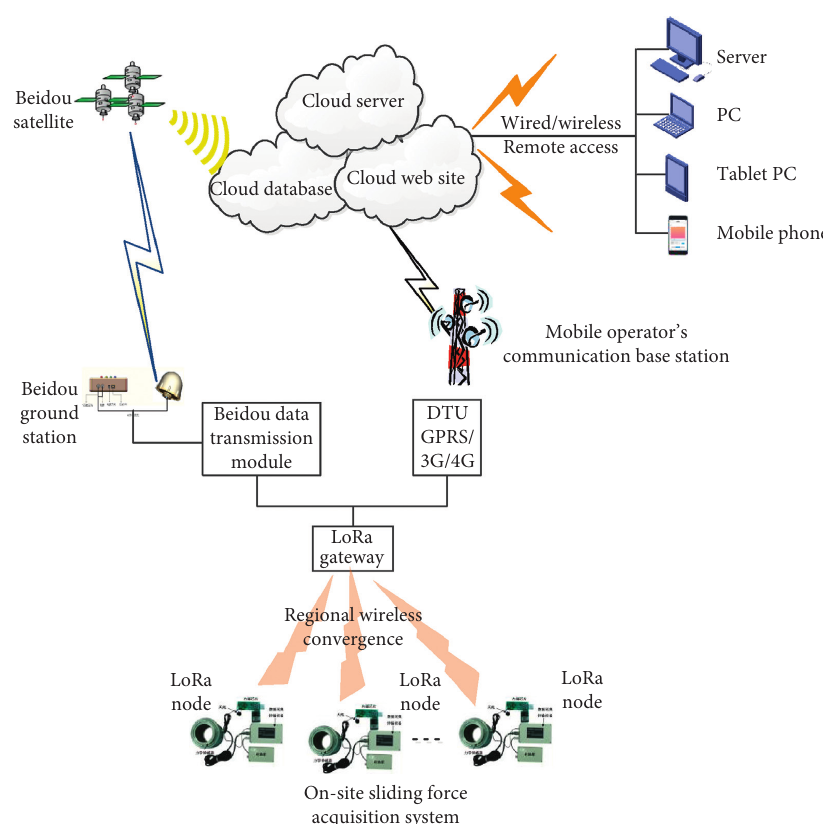
Figure 11: Network communication architecture diagram of the sliding force monitoring